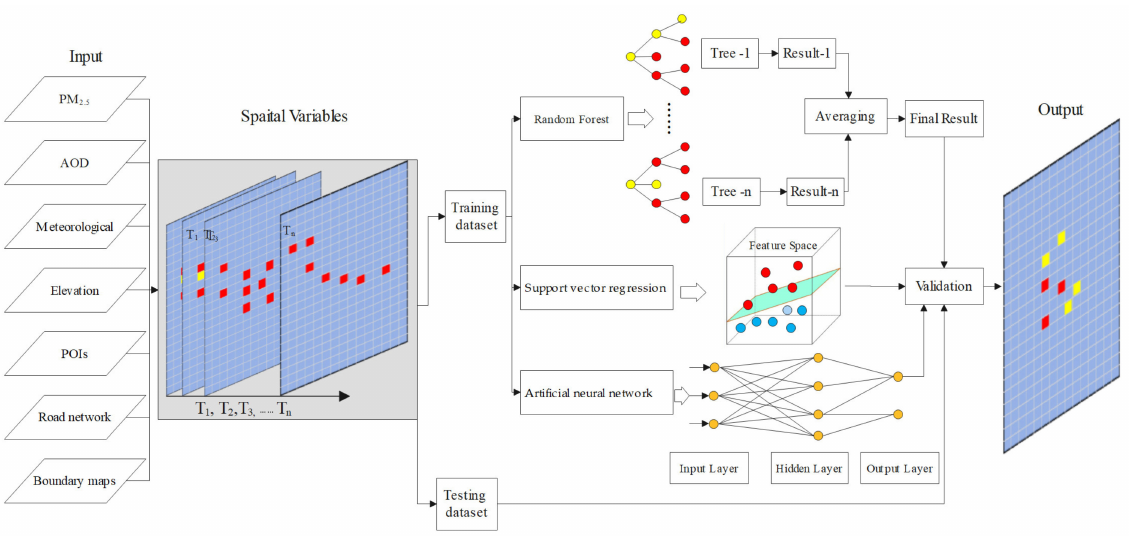
Figure 2. Flowchart for producing and assessing the accuracy of the PM 2.5